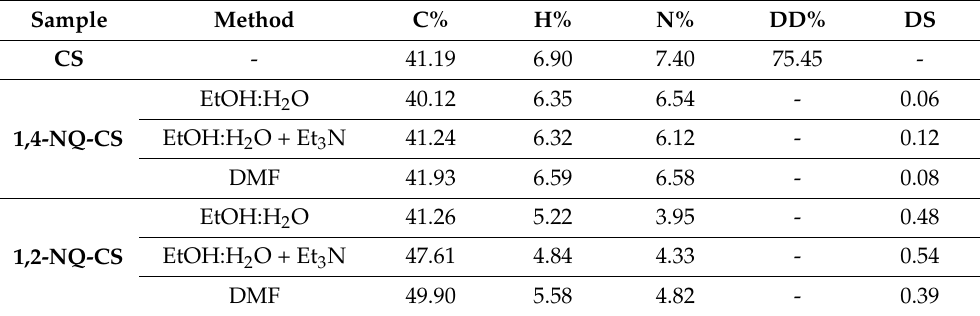
Table 1. Elemental percentage (CHN), deacetylation degree (DD) and degree of substitution (DS) of chitosan (CS) and chitosan grafted with 1,2-naphthoquinone-4-sulfonate (1,2-NQ-CS) and with 1,4-naphtoquinone (1,4-NQ-CS) obtained by three different methods.